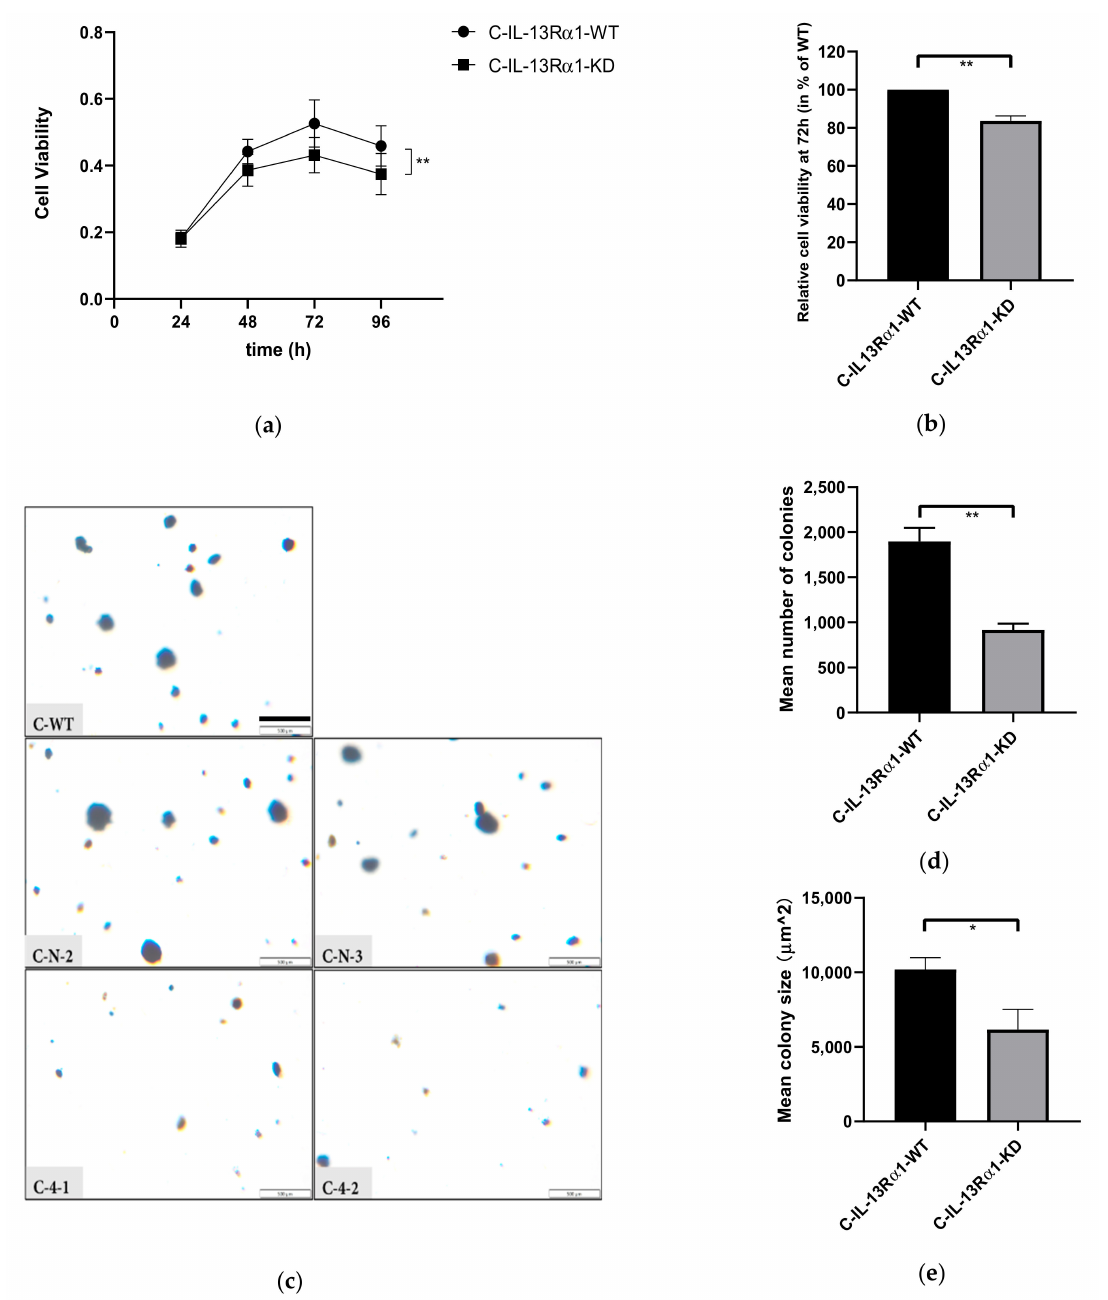
Figure 2. Effect of IL-13R α 1-downregulation on the basal growth of Capan-1 cells. ( a , b ) Anchorage- dependent growth in the MTT assay. ( a ) Cell viability at 24, 48, 72 and 96 h. The absorbance values at 570 nm detected in the MTT assay represent the cell viability and are shown as means of 3 independent experiments of quadruplicate determinations. There is an increasing difference in cell growth of Capan-1 cells with normal IL-13R α 1 expression (C-IL-13-R α 1-WT) and KD clones in a time-dependent manner; ( b ) Relative cell viability at 72 h. Data are shown as mean cell viability in % ( ± SEM) compared to C-IL-13-R α 1-WT and are means of 4 independent experiments of quadruplicate determinations; ( c – e ) Anchorage-independent growth in the colony formation assay; ( c ) Colonies formed in soft agar. Representative pictures show colonies formed by C-WT, C-N-2, C-N-3, C-4-1 and C-4-2 cells growing in soft agar after 21 days at 4x magnification. Scale bar: 500 µ m. Pictures of colonies in 6-well plates were evaluated at random position in each of 9 fields per well. Colonies of C-WT and C-N were more abundant and larger in size; ( d ) Mean number of colonies lager that 50 µ m